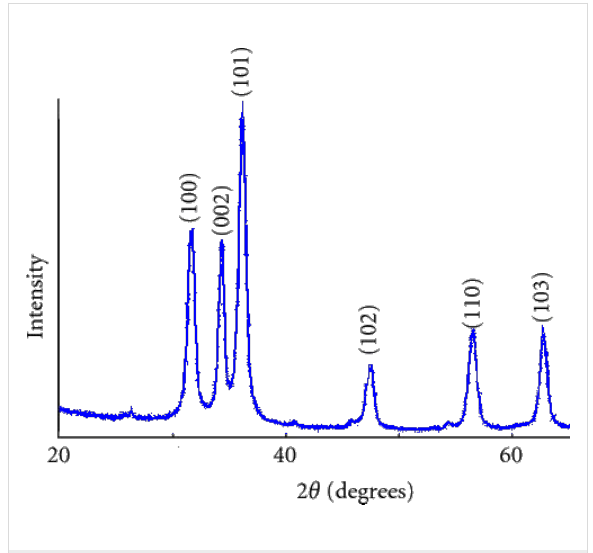
Figure 2: XRD pattern of the produced particles. The reflections were indexed according to the diffraction pattern of hexagonal wurtzite-type